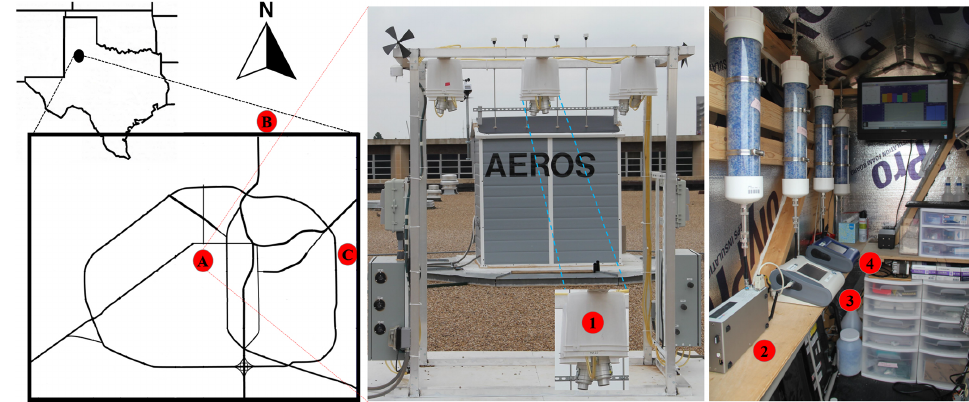
Figure 1. Location of AEROS (A) in the Southern High Plains of West Texas with locations of meteorological station (B) and the TCEQ PM 2 . 5 station (C). The photos show the filter sampler unit with Harvard Impactor (HI;1) units and the aerosol measurement unit (outside and inside views with dryers and instruments 2-Grimm 11-D, 3-OPS, and